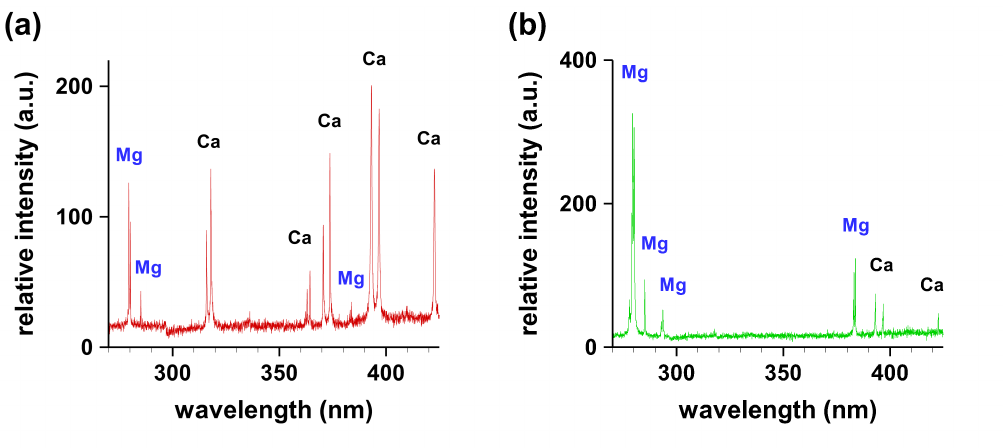
Figure 2. Typical recorded spectral signatures from granules of granular gallstone in the range of 270–450 nm. ( a ) Center; ( b ) periphery.